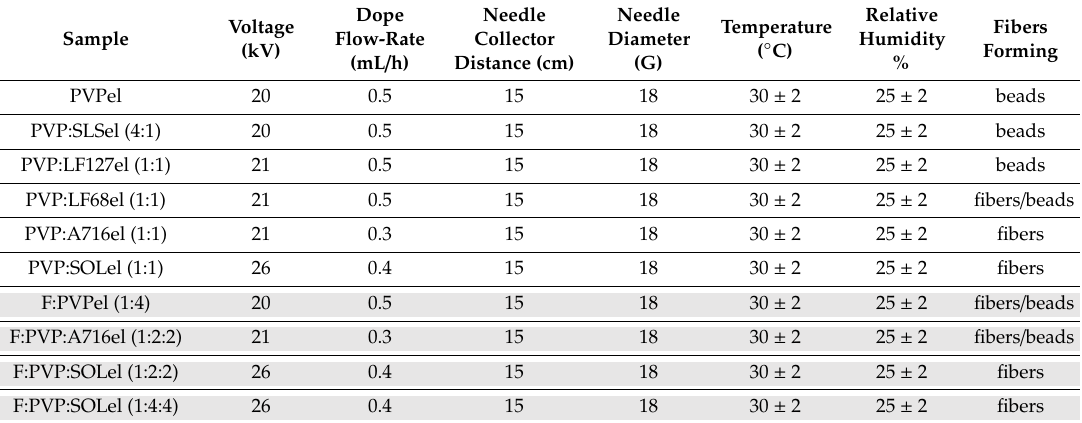
Table 1. Electrospinning process parameters optimized for each sample solution. The samples of the solutions prepared with firocoxib are reported in the last light grey